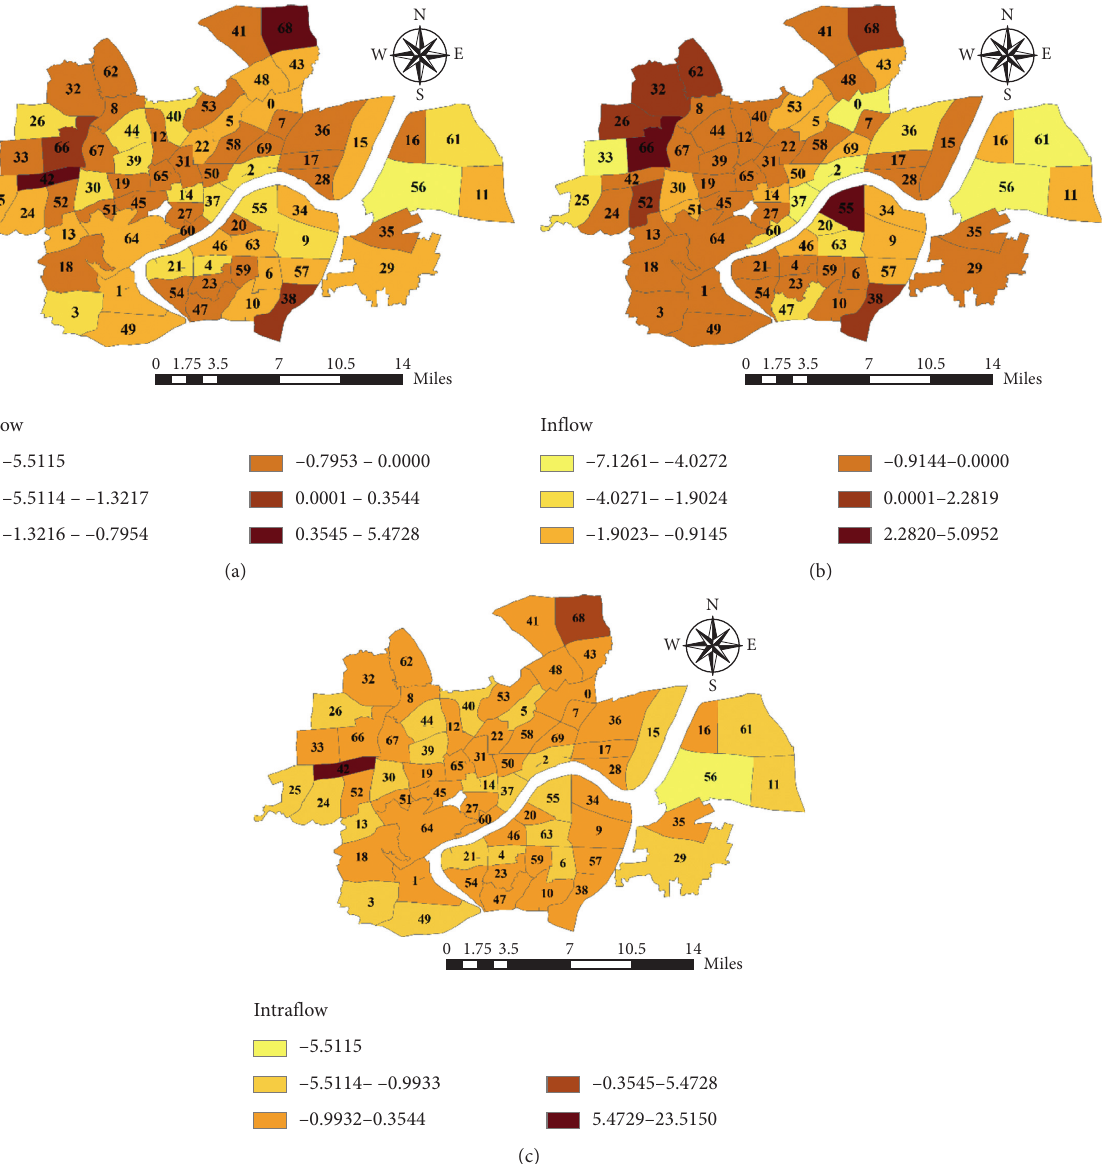
Figure 8: OD flow changes due to subway development by 2022. (a) Outflow change ratio. (b) Inflow change ratio. (c) Intraflow change